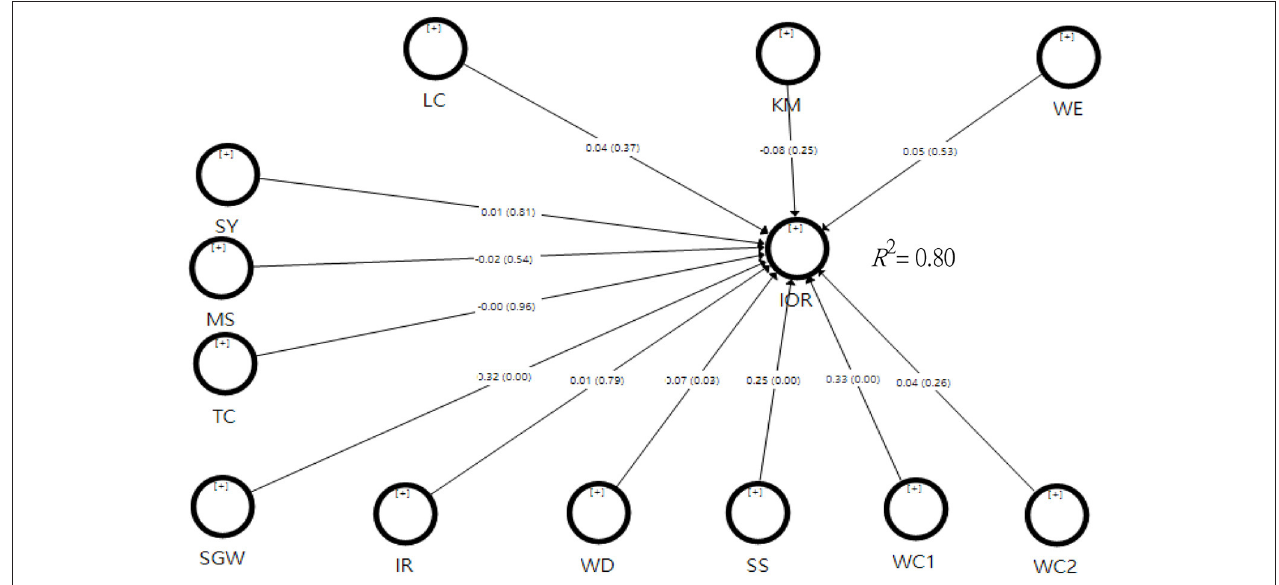
FIGURE 2 | Test results of the overall model.